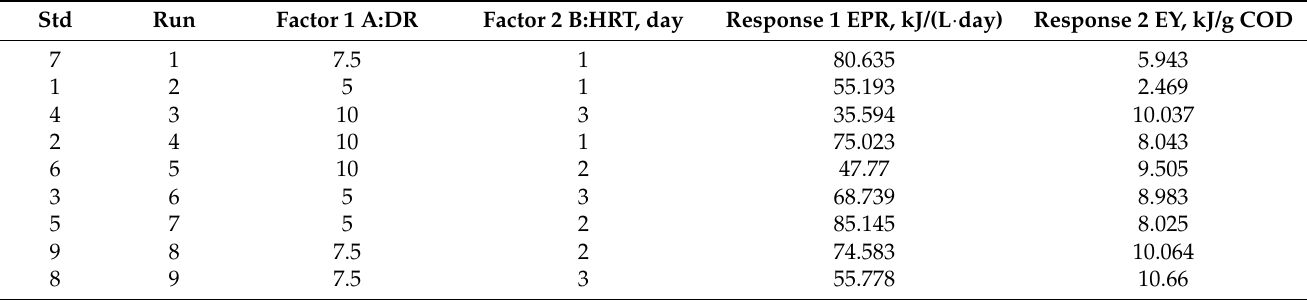
Table 4. Experimental design of the model.